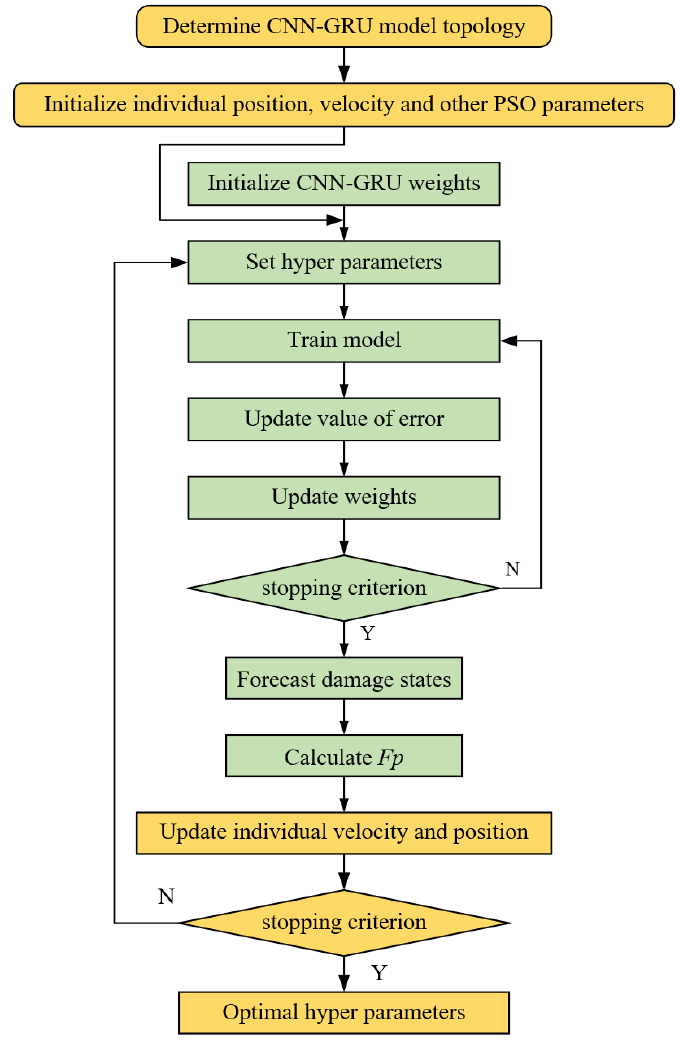
Figure 3. The flowchart of the PCG model.